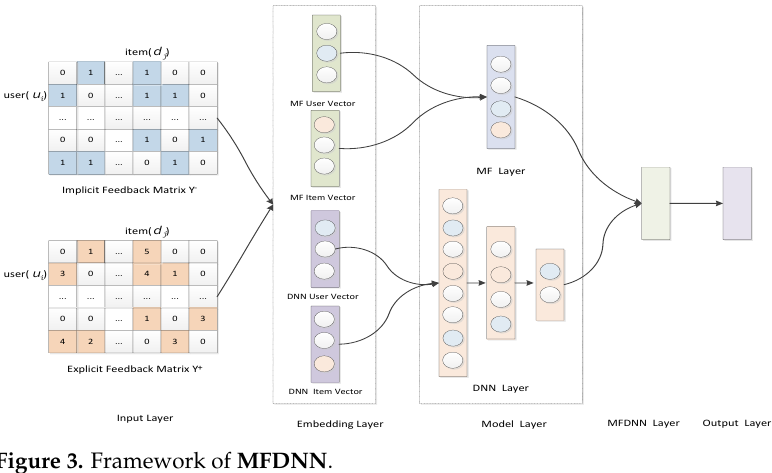
Figure 3. Framework of MFDNN